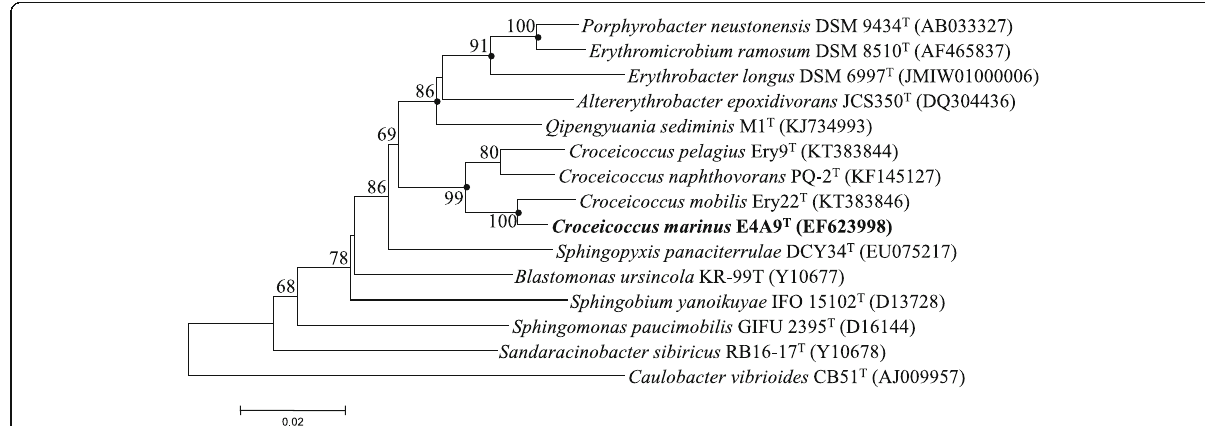
Fig. 2 Phylogenetic tree based on 16S rRNA gene sequences was constructed by neighbor-joining algorithms. Related sequences were aligned with Clustal W. Evolutionary distances were calculated according to the algorithm of the Kimura two-parameter model. Bootstrap values (> 60%) based on 1000 replications are shown at branch nodes. Filled circles indicate that the corresponding nodes were also recovered in the trees generated with the maximum-likelihood and maximum-parsimony algorithms. Bar, 0.01 substitutions per nucleotide